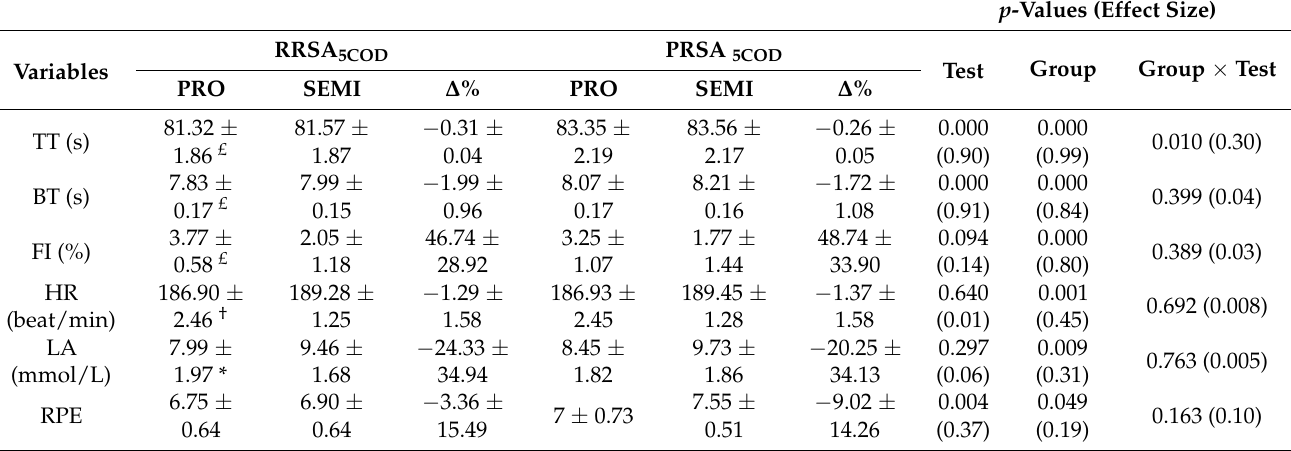
p -Values (Effect Size)